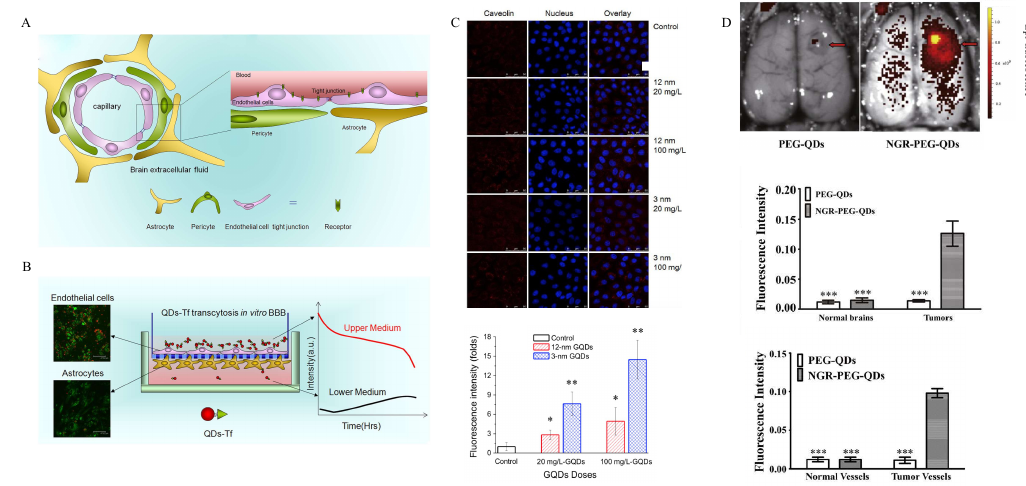
Figure 4. GQDs across the blood-brain barrier (BBB). ( A ) Structure of the BBB [75]; ( B ) In vitro permeability via transwell in a co-culture system. ( A , B ) were reprinted with permission [75]. Copyright 2008, American Chemical Society; ( C ) Transcellular transport mechanism across a biological barrier made of canine kidney MDCK cells with di ff erent sizes of GQDs. Scalebar 50 µ m. * was for p < 0.05, ** was for p < 0.01, and *** was for p < 0.001 over control. Reproduced with permission from The Royal Society of Chemistry [73]; ( D ) Uptake of PEG-GQDs functionalized with a ligand of CD13, capable of recognizing glioma and tumor vessels. *** was for p < 0.001 over control. Adapted from [84]. Copyright 2017, permission from